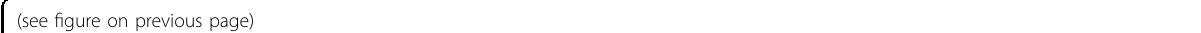
Fig. 1 SA- β -gal-positive cells are transiently reduced in response to lipid peroxidation during ferroptosis. A – C WT MEFs were exposed to erastin for 24 h. A Optical microscope image. B , C Quanti fi cation of dead cells ( B ) and SA- β -gal-positive cells ( C ) by fl ow cytometer. D – F NIH3T3 cells were exposed to erastin for 24 h. D Optical microscope image. E , F Quanti fi cation of dead cells ( E ) and SA- β -gal-positive cells ( F ) by fl ow cytometer. G WT MEFs were exposed to erastin for 24 h. Optical microscope image after SA- β -gal staining. H – J After WT MEFs had been exposed to erastin for 24 h, they were passaged in culture medium (not including erastin) and cultured for 48 h. H Experimental outline. I Representative data of histogram of SA- β -gal fl uorescence by fl ow cytometer. Values on the upper left and upper right represent respectively the percentage of negative and positive cells. The colors correspond to histogram traces. J Quanti fi cation of SA- β -gal-positive cells by fl ow cytometer. K – M NIH3T3 cells were exposed to erastin and Fer-1 for 24 h. K Optical microscope image. L , M Quanti fi cation of dead cells ( L ) and SA- β -gal-positive cells ( M ) by fl ow cytometer. N – P WT MEFs were exposed to erastin for 12 h. N Optical microscope image. O , P Quanti fi cation of dead cells ( O ) and SA- β -gal-positive cells ( P ) by fl ow cytometer. Q – S Bach1 − / − MEFs were exposed to erastin for 24 h. Quanti fi cation of dead cells ( Q ) and SA- β -gal-positive cells ( R ) by fl ow cytometer, and optical microscope image after SA- β -gal staining ( S ). Scale bars in A , D , G , K , N , and S represent 100 µm. Q and R are representative of three independent experiments. A – P and S are representative of two independent experiments carried out in triplicate. Error bars of B , C , E , F , J , L , M , O , P , Q , and R represent SD. P value of B , C , E , F , J , O , P , Q , and R by two-sided t test. P value of L and M by Tukey ’ s test after two-way